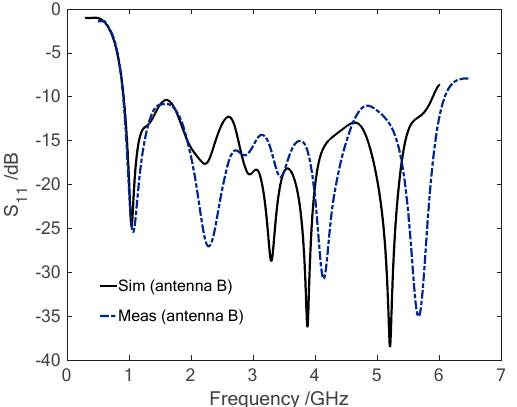
Figure 10. Reflection coefficients of the proposed antenna B, comparing the measured result with the simulation.